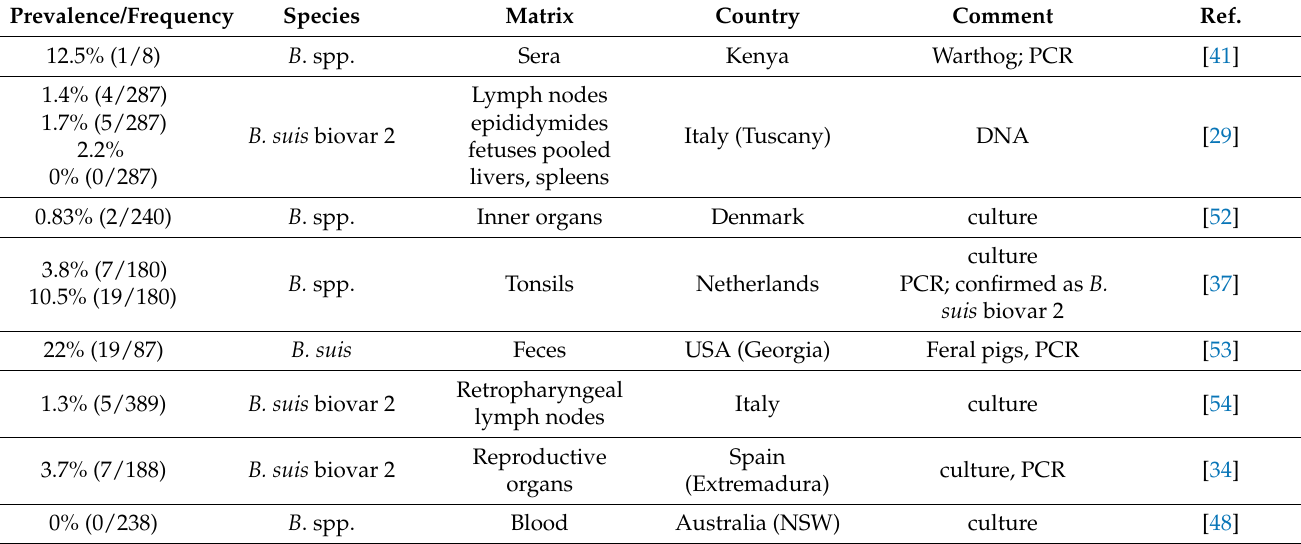
Table 3. Prevalence of Brucella spp. (viable bacteria or DNA) in wild boar (2012–2022), by country and